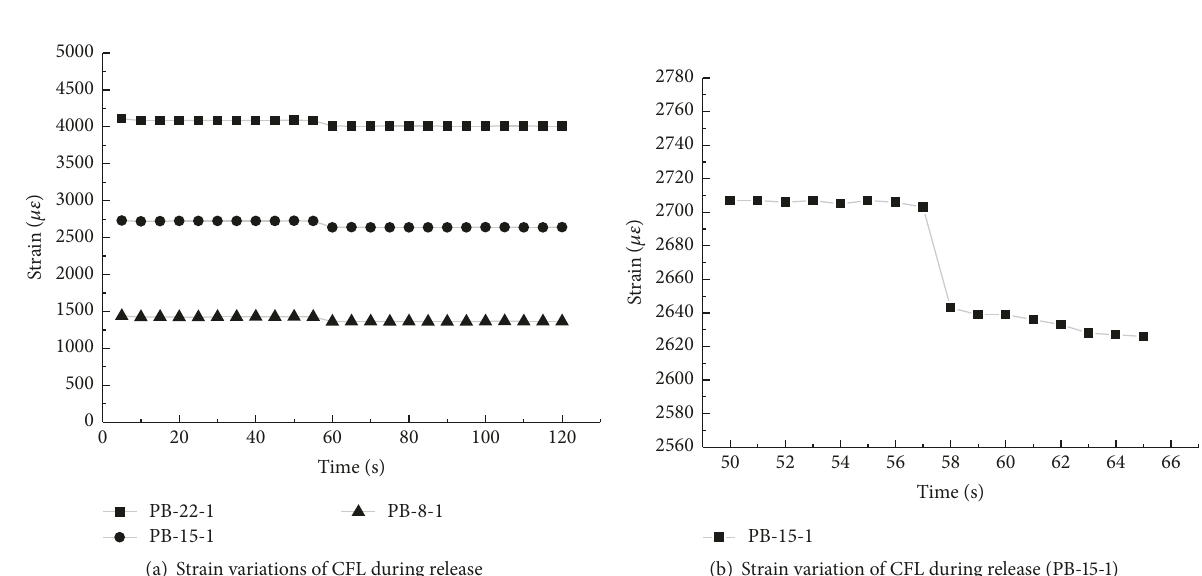
Figure 8: Strain variations of CFL during curing.